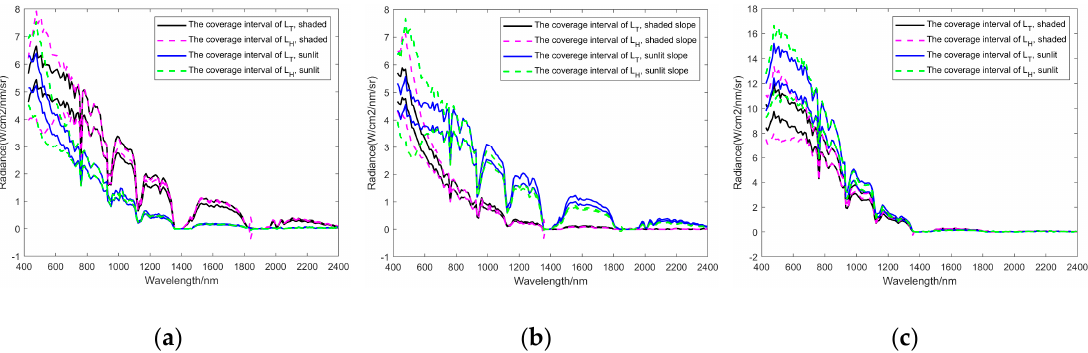
Figure 12. The uncertainty coverage intervals before and after C correction. ( a ) The coverage interval of soil over a flat terrain; ( b ) the coverage interval of soil over a rugged terrain; ( c ) the coverage interval of snow over a flat terrain. In each subplot, the solid and dashed lines are respectively the uncertainty coverage intervals before and after C correction; the black and pink lines are verification points on the shaded slope, while the blue and green lines are verification points on the sunlit slope.